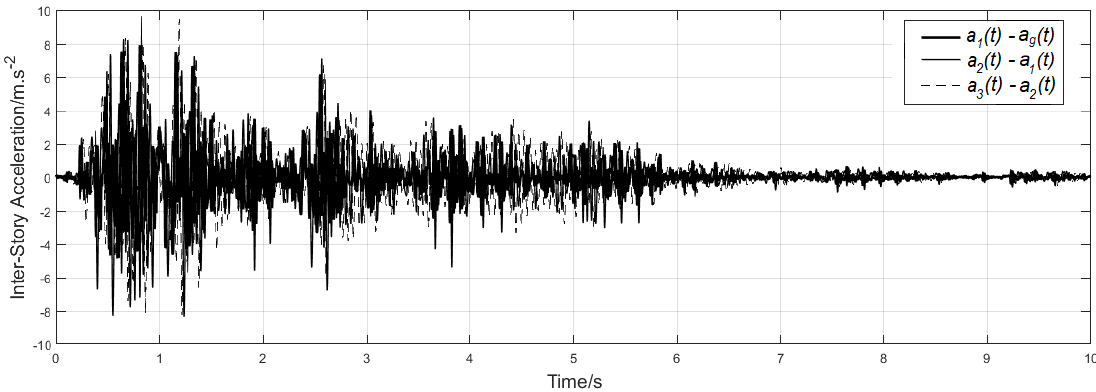
Figure 11. The building closed-loop acceleration response to the earthquake, assuming an empirically tuned BELBIC controller.